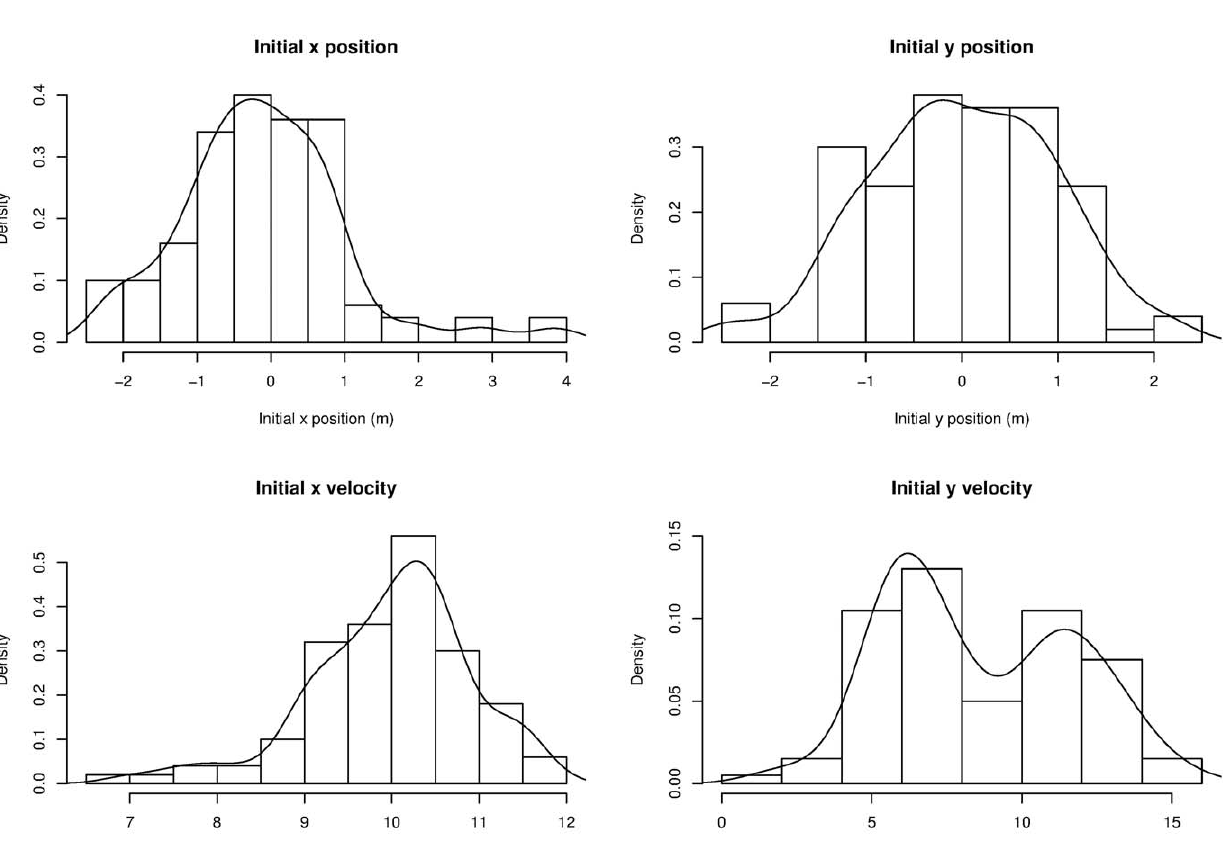
Figure 1. The distribution of the initial position in x and y, and the initial x and y velocity components of the object, shown using both a density histogram and a kernel density plot. Generated using Model S1.